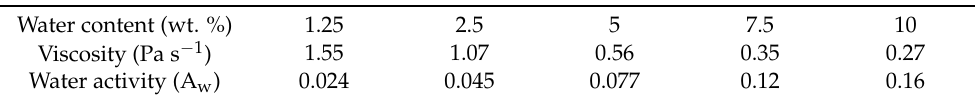
Table A1. Averaged values of viscosity and water activity of the Sorbit DES under various water contents at 50 ◦ C. Water content (wt.